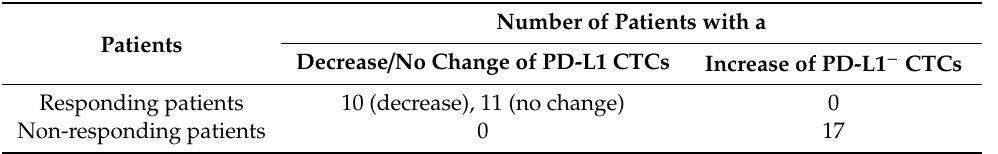
Table 1. Changes in PD-L1 +/ − CTCs in relation to the clinical response to regorafenib. CTCs detected at baseline and after starting treatment.